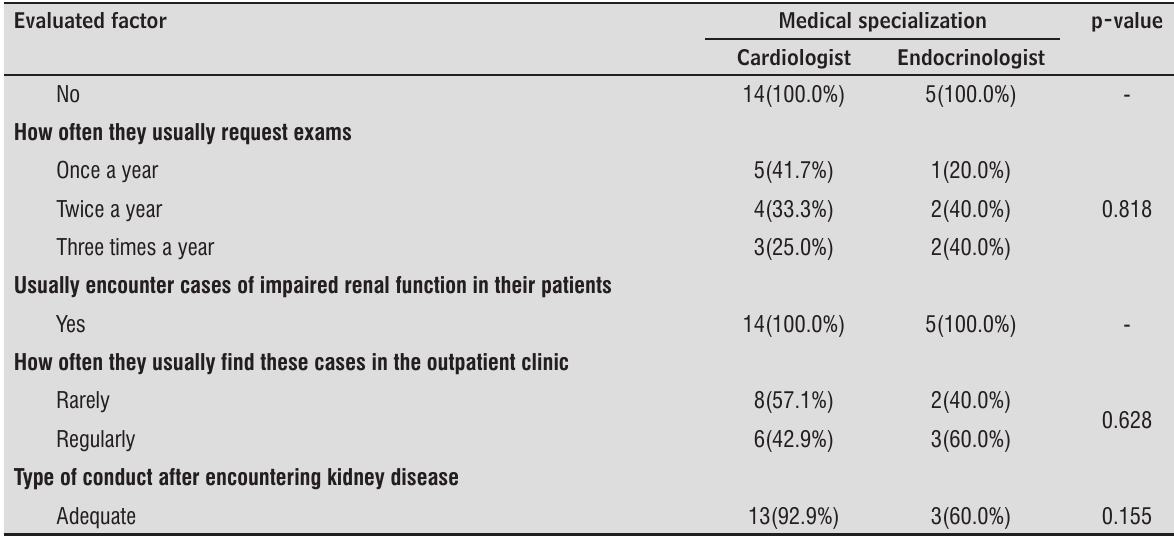
Table 2 - Characteristics regarding the evaluation of renal function between cardiologists and endocrinologists Evaluated